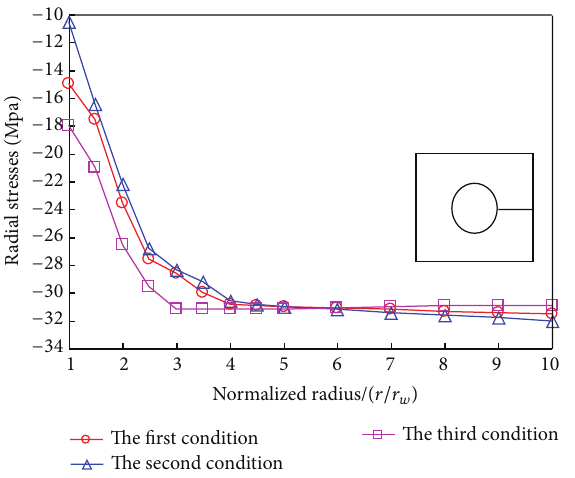
Figure 19: Distribution of the tangential stress in borehole under different